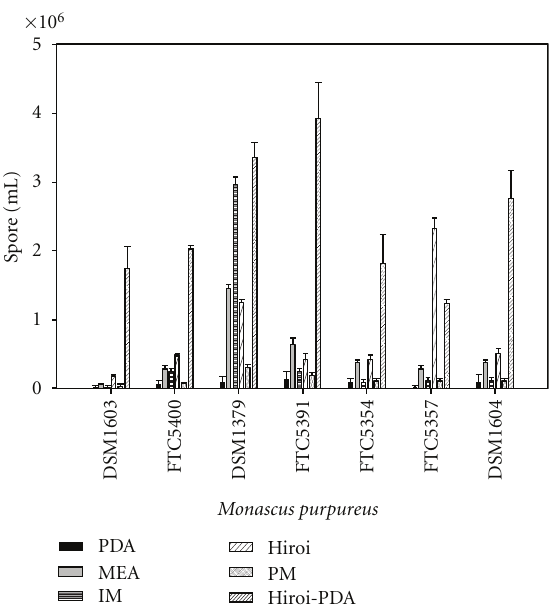
Figure 1: Comparison of colony mean radius for di ff erent strains of Monascus spp after 12 days of cultivation on di ff erent media. Data are average of three determinations (mean ± SD).